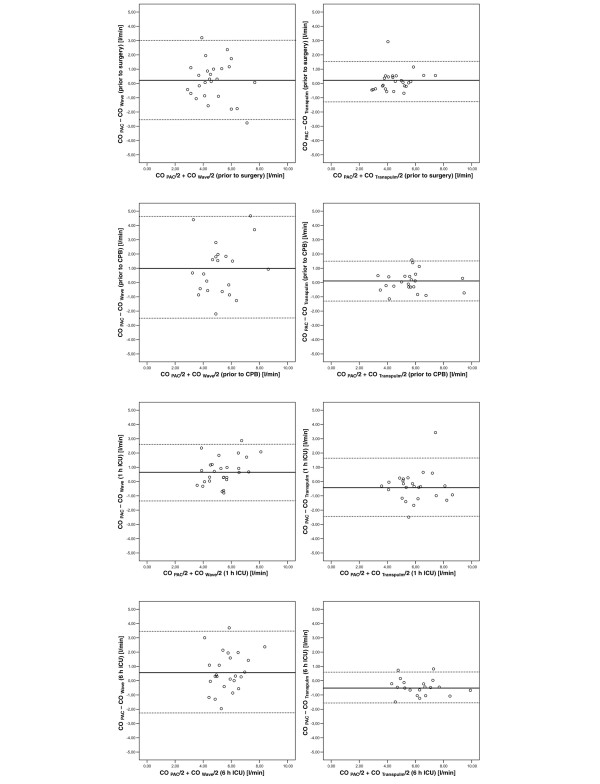
Bland-Altman plots of COPAC versus COWave and of COPAC versus COTranspulm for each individual point of measurement. COPAC, pulmonary artery catheter thermodilution cardiac output; COTranspulm, aortic transpulmonary thermodilution cardiac output; COWave, uncalibrated pulse contour cardiac output; CPB, cardiopulmonary bypass; 1 h ICU, one hour after admission to the intensive care unit; 6 h ICU, six hours after admission to the intensive care unit.